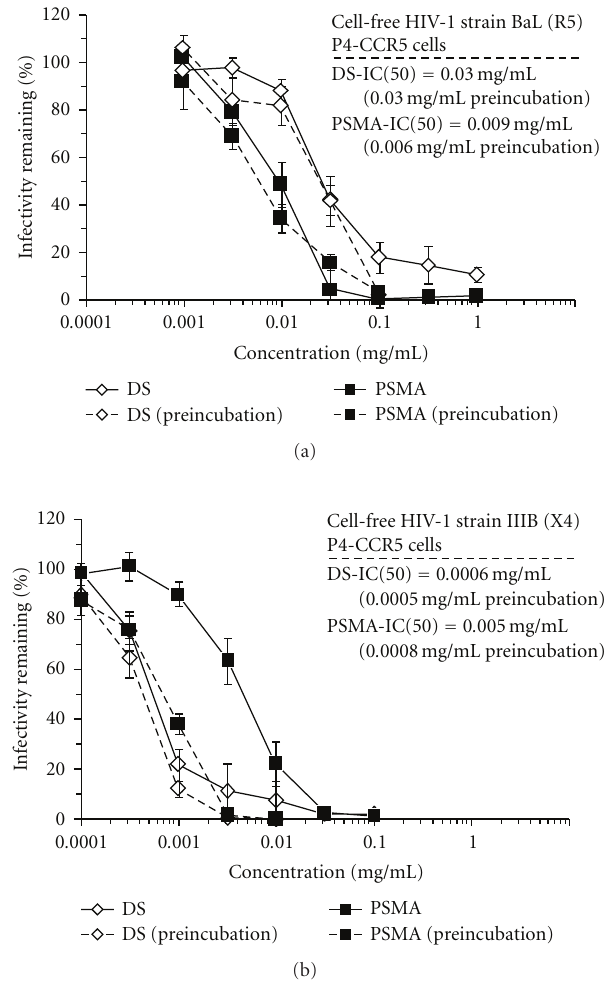
Figure 2: alt -PSMA inhibits infection by HIV-1 strains BaL and IIIB. P4-R5 MAGI cells were incubated for 2h with HIV-1 strains (a) BaL or (B) IIIB in the absence or presence of alt -PSMA or DS (as described in Section 2). For the preincubation portion of the experiment, compound and virus were first incubated for 10min prior to dilution and addition to cells. Infectivity remaining was expressed relative to mock-treated, HIV-1-infected cells and graphed against the compound concentration achieved during the 2-h incubation. Each concentration was examined in triplicate in two independent